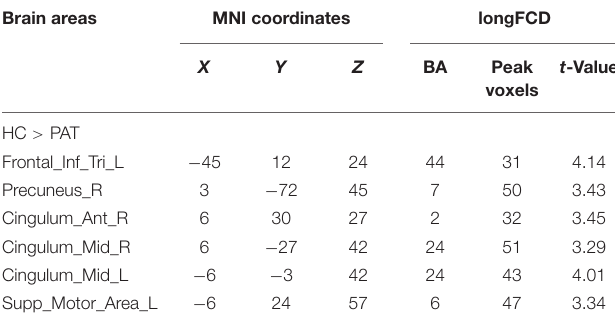
TABLE 2 | The binarized longFCD differences between the ON and HC